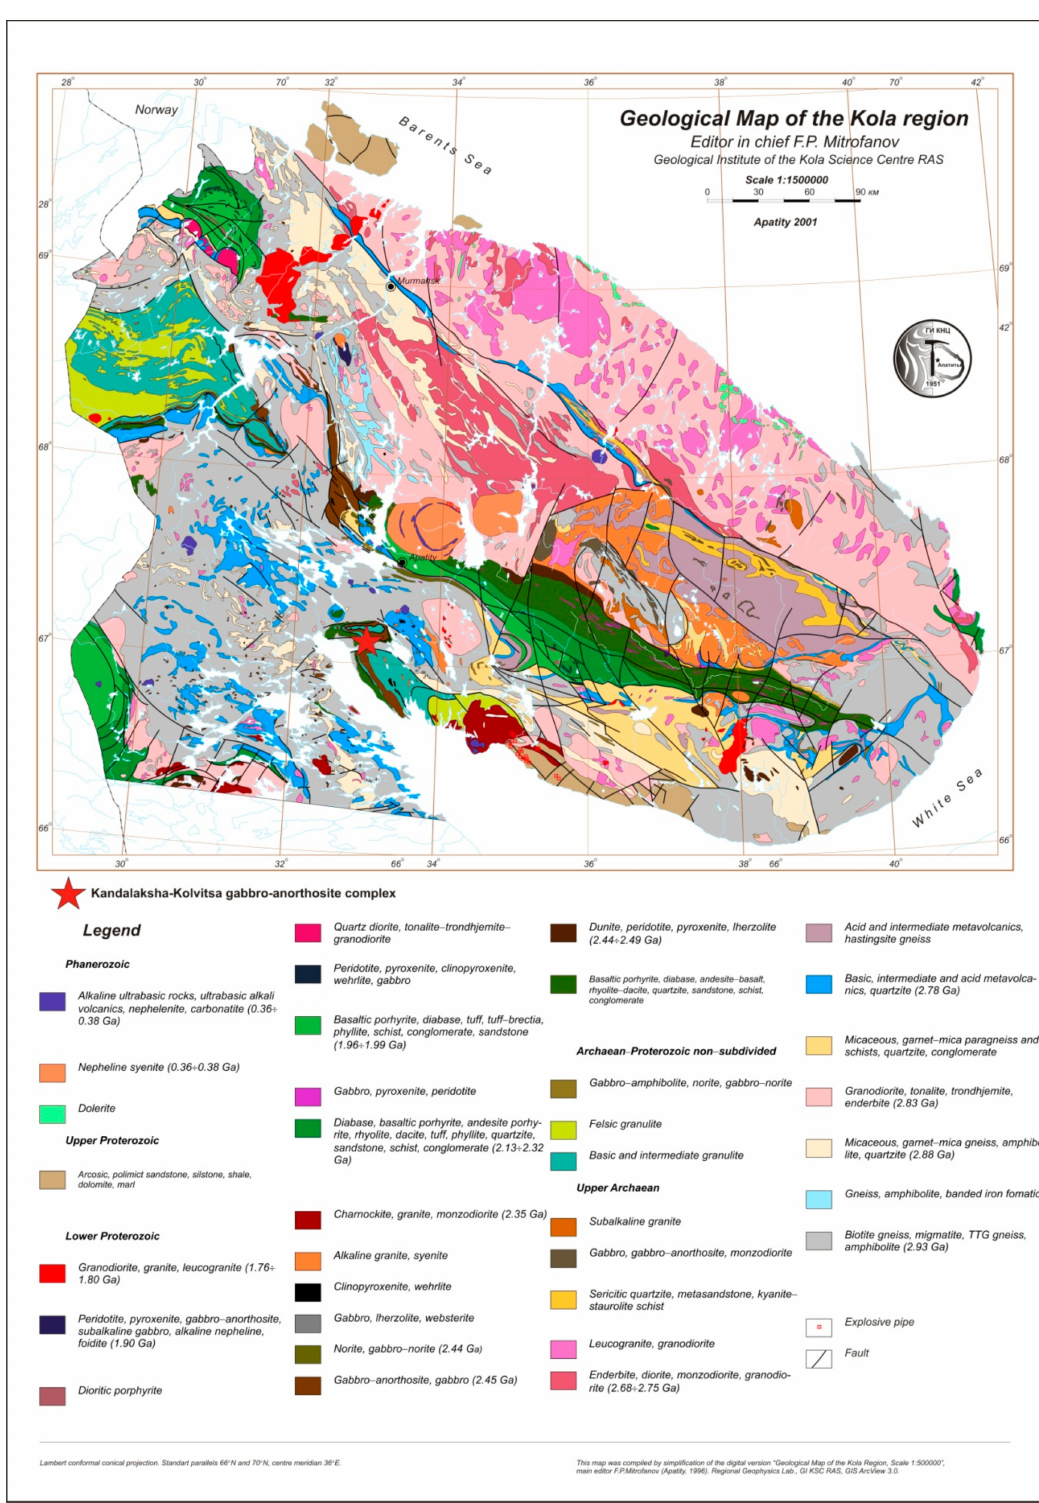
Figure 1. Geological map of the Kola region